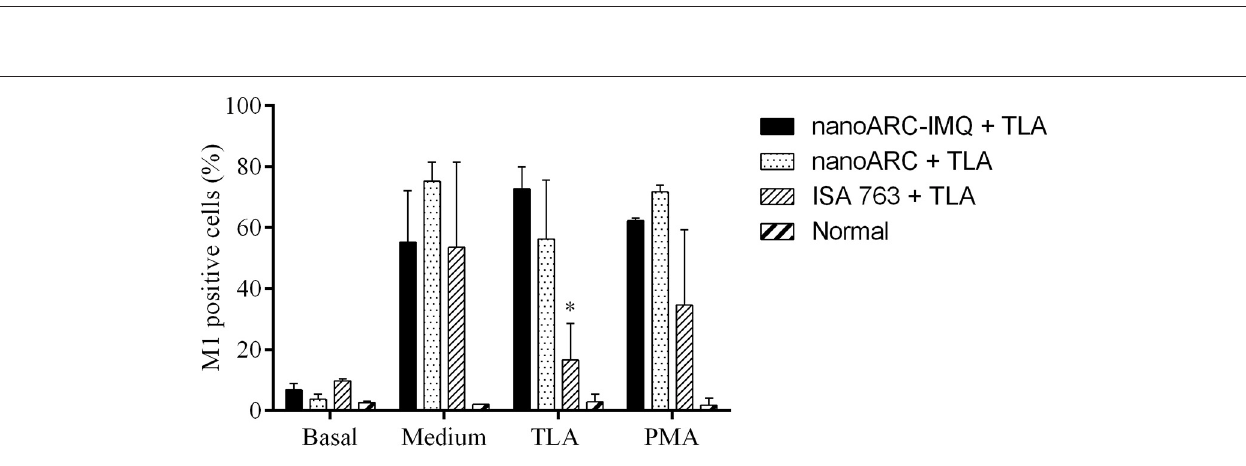
Frontiers in Bioengineering and Biotechnology | www.frontiersin.org